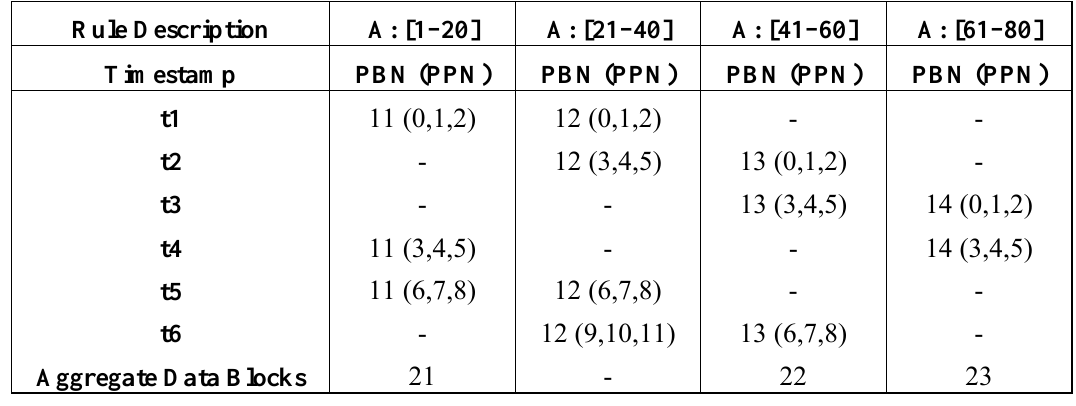
Table 5. Query processing